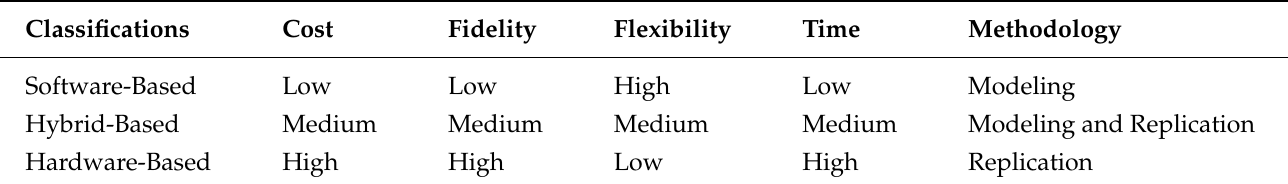
Table 1. Classification of Testbed Based on